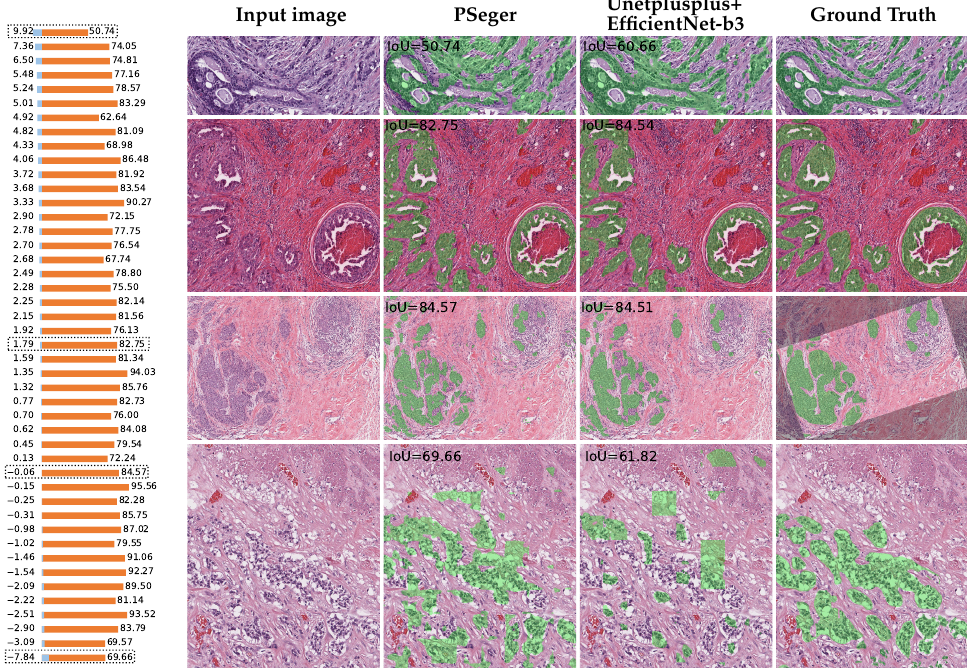
Figure 6. Comparison between PSeger and Unetplusplus+EfficientNet-b3. Left: IoU values (orange bars) of PSeger on 45 tested ROIs and their differences (sky-blue bars) with those of Unetplusplus+EfficientNet-b3. The bar pairs are sorted in descending order of the values of the blue bars. Right: Images of four representative cases. From top to bottom, rows are case 1–4, also framed by black dotted rectangles in the bar graph on the left. From left to right, columns are input images, segmentation results by PSeger, segmentation results by Unetplusplus+EfficientNet-b3, and ground truths. Green overlays are annotated or predicted tumor regions, black overlays are ignored regions, and others are non-tumor regions.